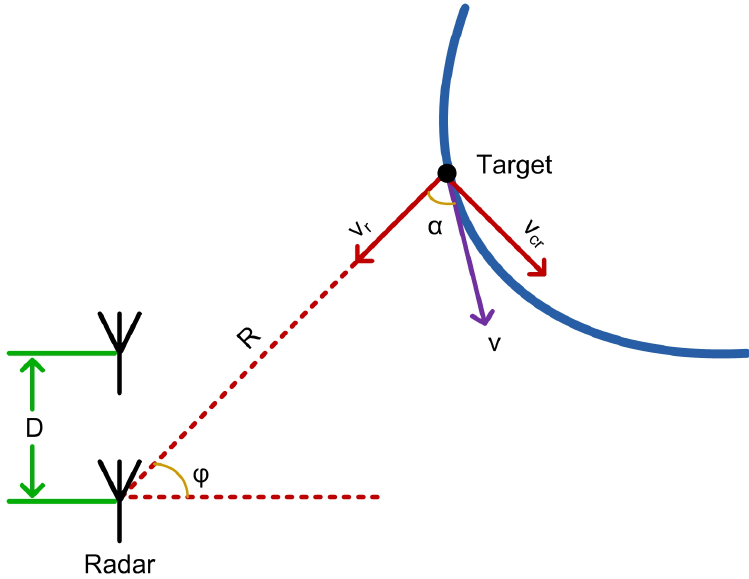
Figure 1. The representation of a moving point source’s instantaneous linear